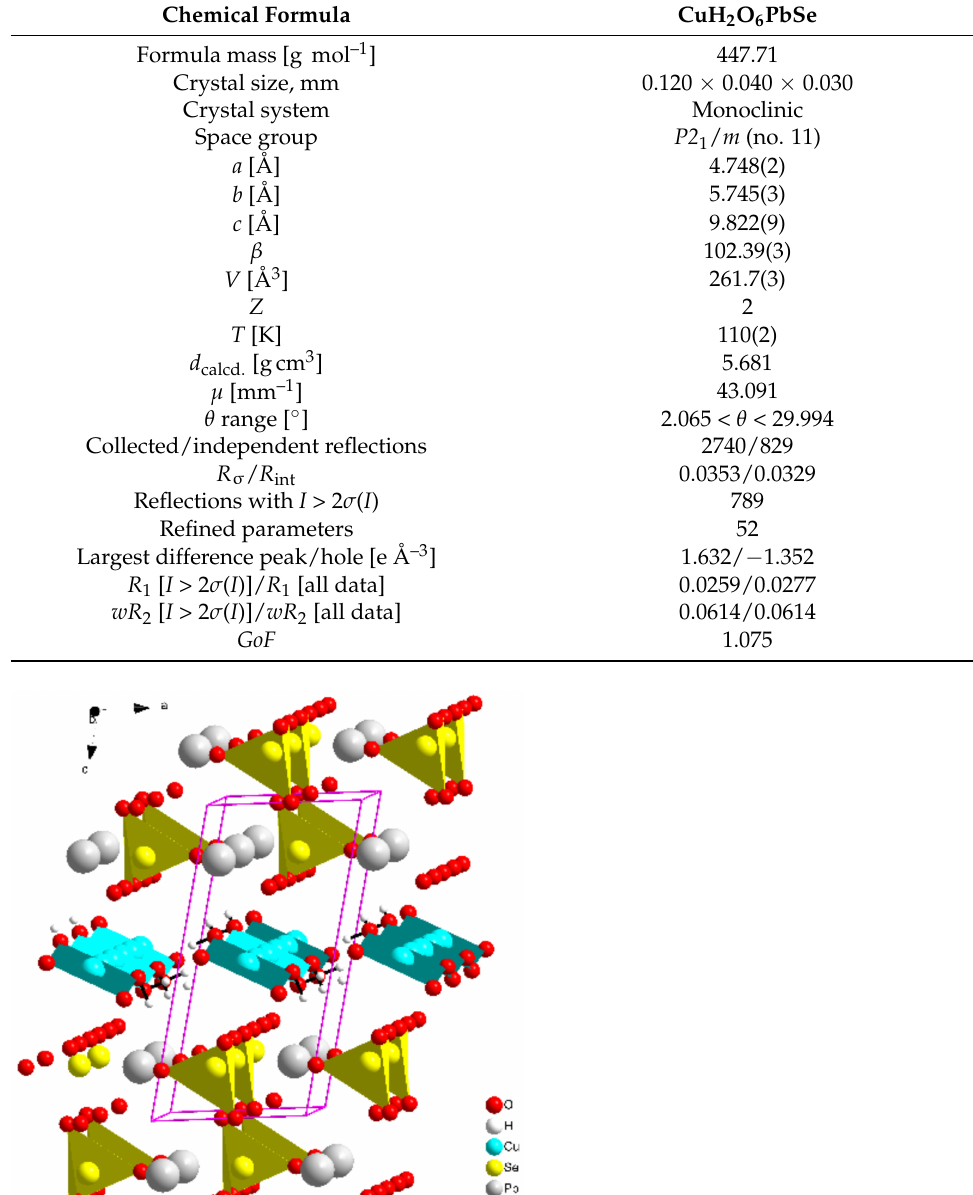
Table 1. Selected crystallographic data and refinement parameters for PbCu(SeO 4 )(OH) 2 from single-crystal X-ray diffraction.